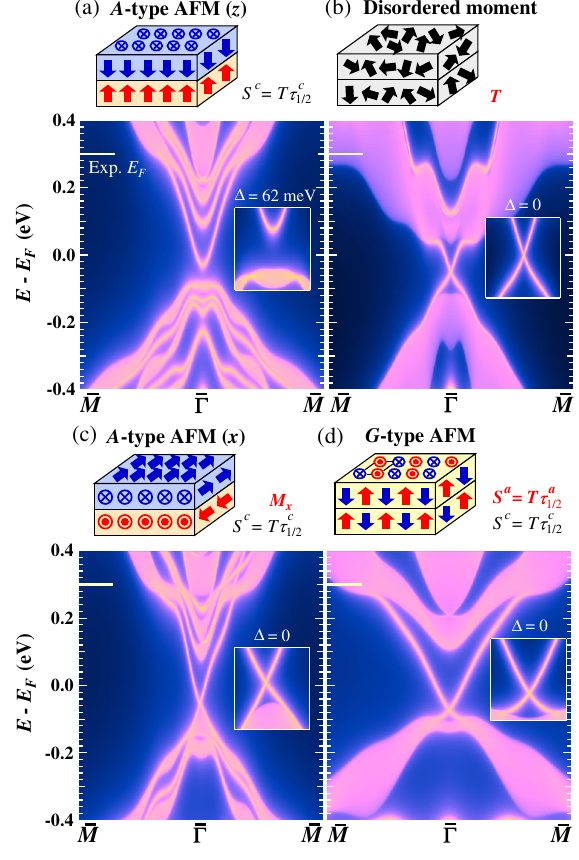
FIG. 4. DFT-calculated surface states of MnBi 2 Te 4 for four prototypical magnetic configurations. (a) A -type AFM with the magnetic moments along the z axis, (b) disordered magnetic moments, (c) A -type AFM with the magnetic moments along the x axis, and (d) G -type AFM. The top drawing in each panel specifies the magnetic configuration and the symmetries that preserve in bulk (black) and (0001) surface (red). T , time reversal; τ i 1 ( i ¼ a , b , c ), half-cell translation along i ; M , = 2 mirror